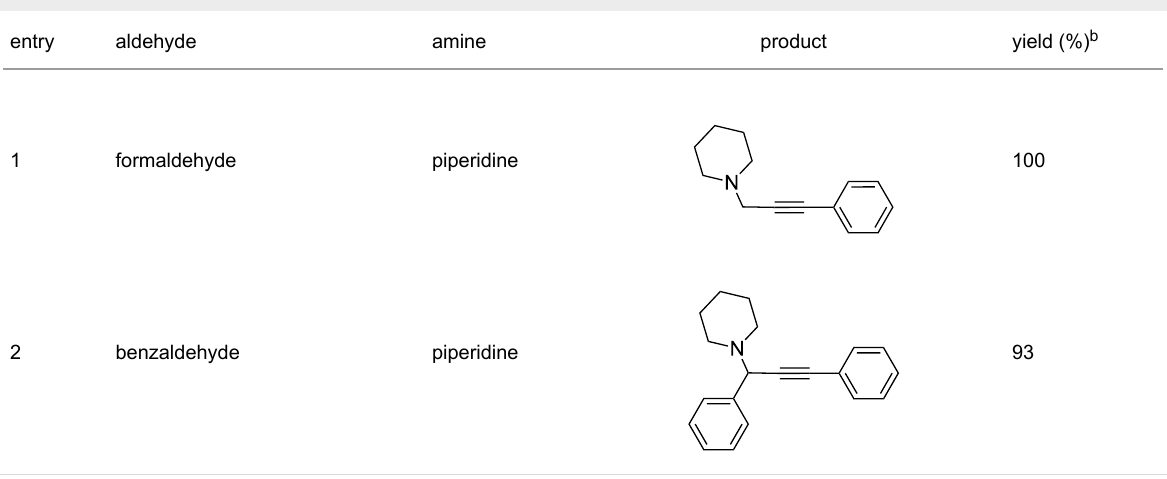
Table 2: Three-component coupling of aldehyde, amine, and phenylacetylene catalyzed by Au@SH-CNC catalysts in solvent-free conditions.